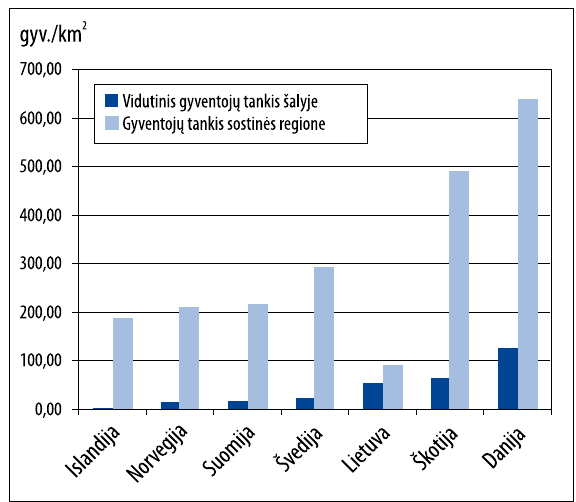
Fig. 2. Po pu la tion den si ty – ave ra ge in the coun try and in ca pi tal re gions of Lit hu a nia, Scan di na via and Scot land